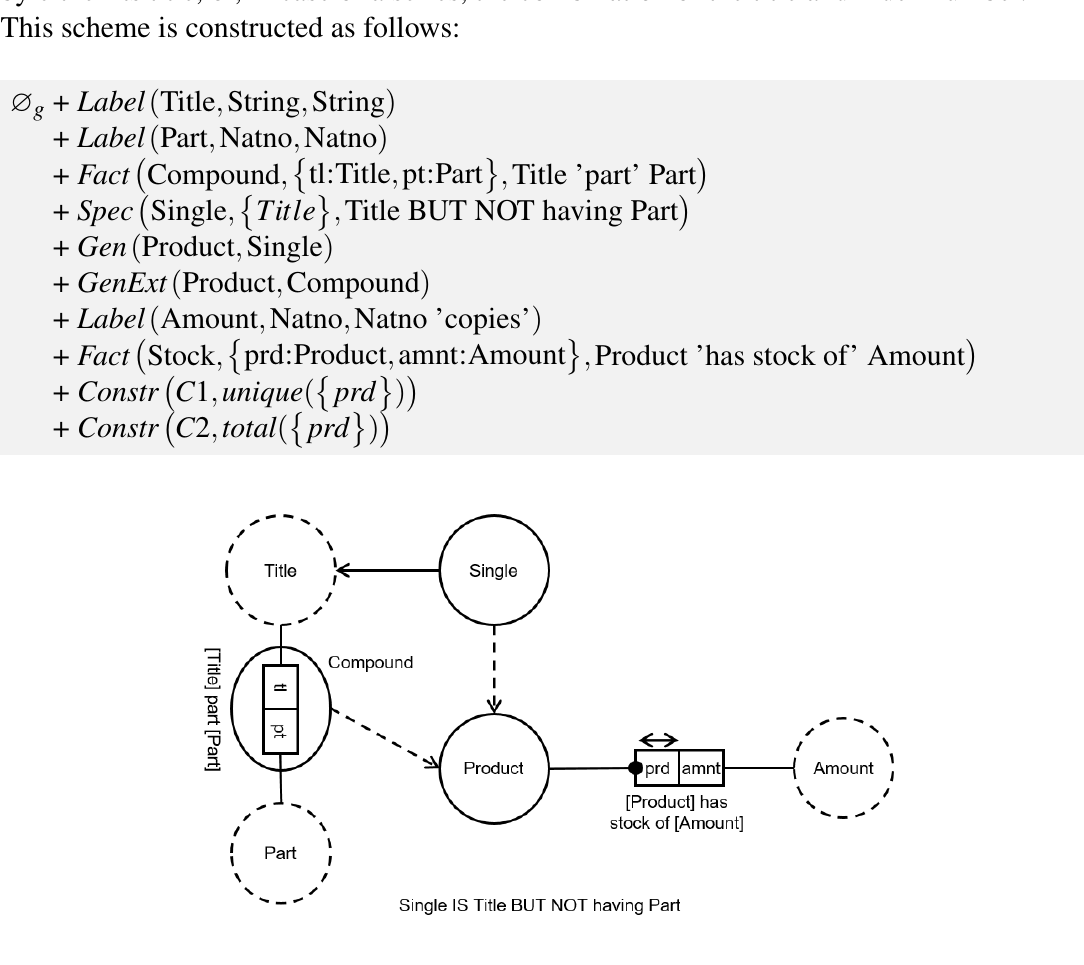
Figure 13. Book inventory